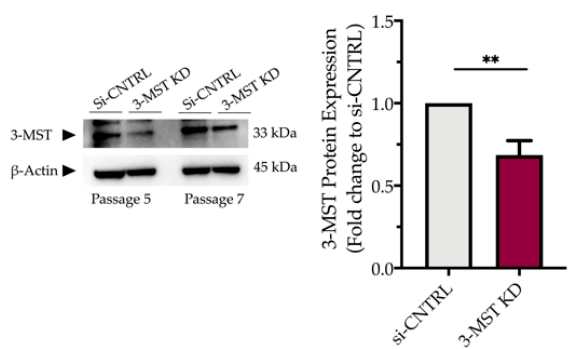
Figure 8. Partial efficacy of 3-MST silencing using siRNA. Quantification of 3-MST protein levels and representative blot pictures following RNA interference. Each bar represents mean ± SEM from four independent cell transfections. Data are expressed as a fold change of the transfection negative control (si-CNTRL); ** p ≤ 0.01.